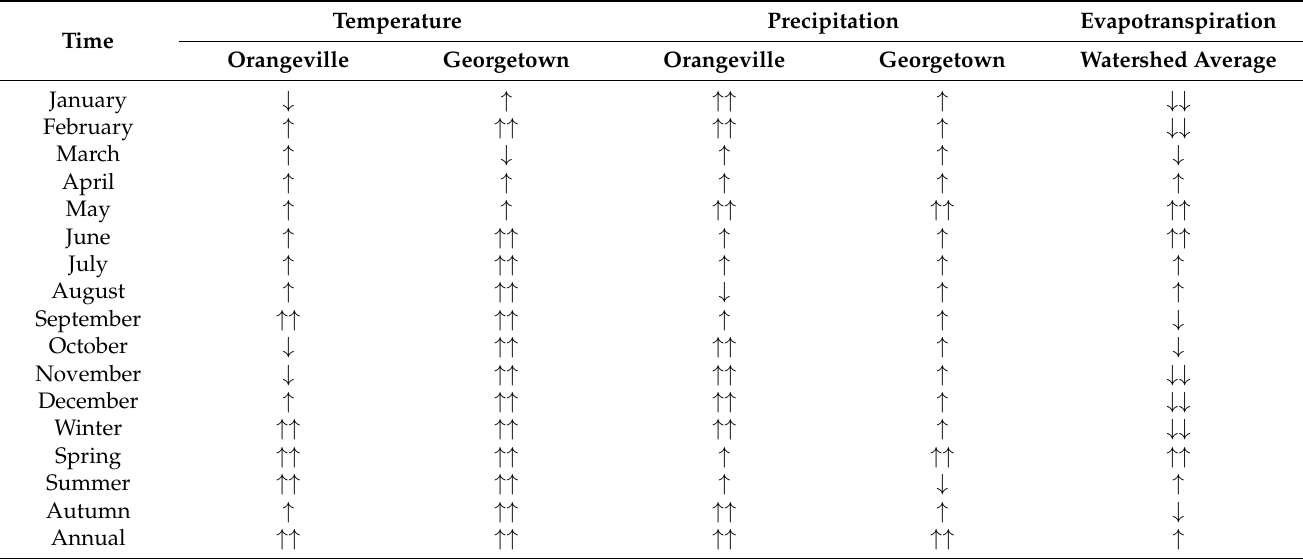
Table 3. Results of the monthly, seasonal, and annual trend analysis of the temperature, precipitation, and evapotranspiration for the period 1950–2019.